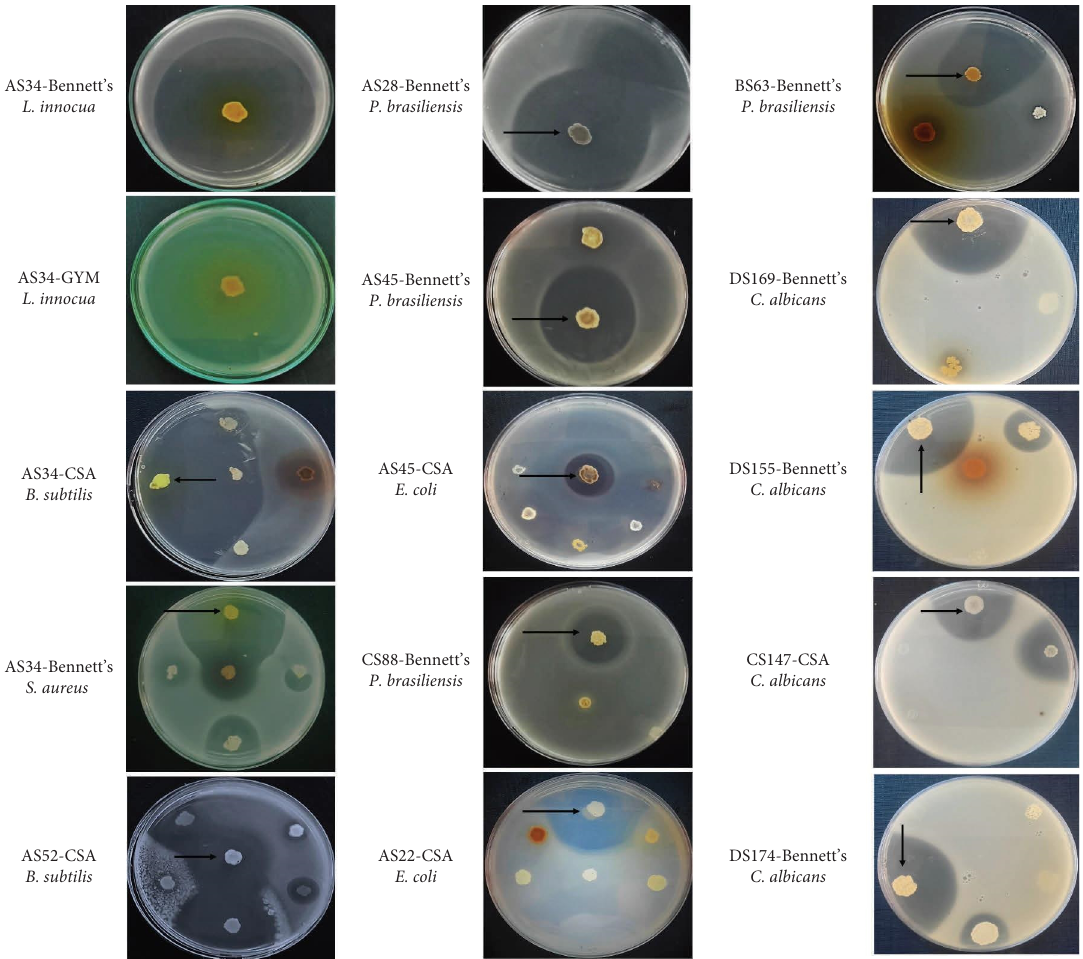
Figure 7: Selected representative examples of isolates showing antimicrobial activities. Isolates codes-media, and tested microorganisms are noted and the arrow indicates the active